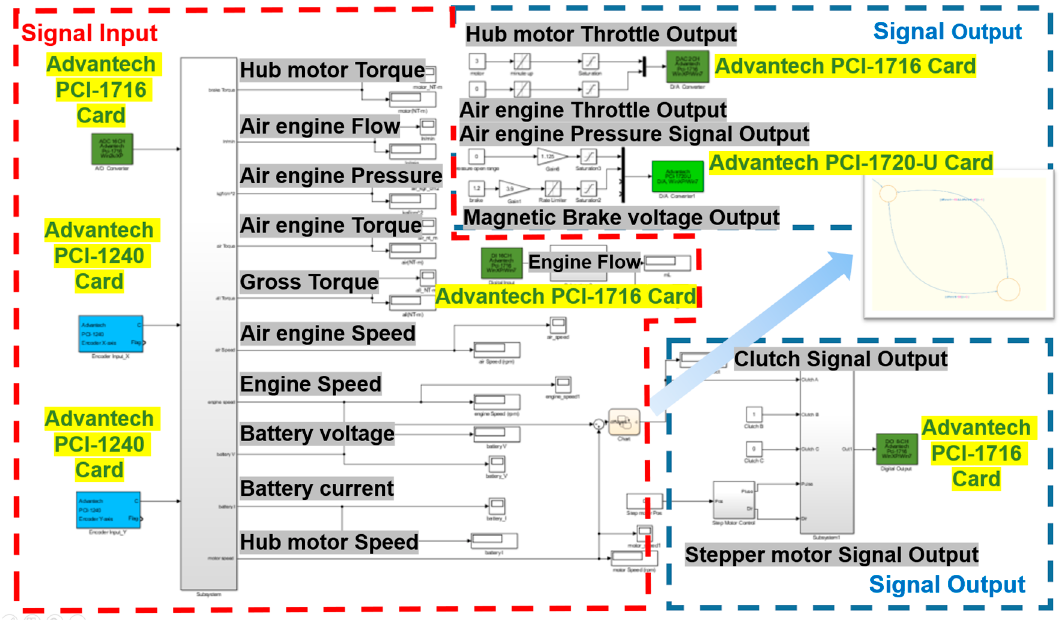
Figure 4. Matlab / Simulink input / output control block Figure 4. Matlab/Simulink input/output control block diagram .